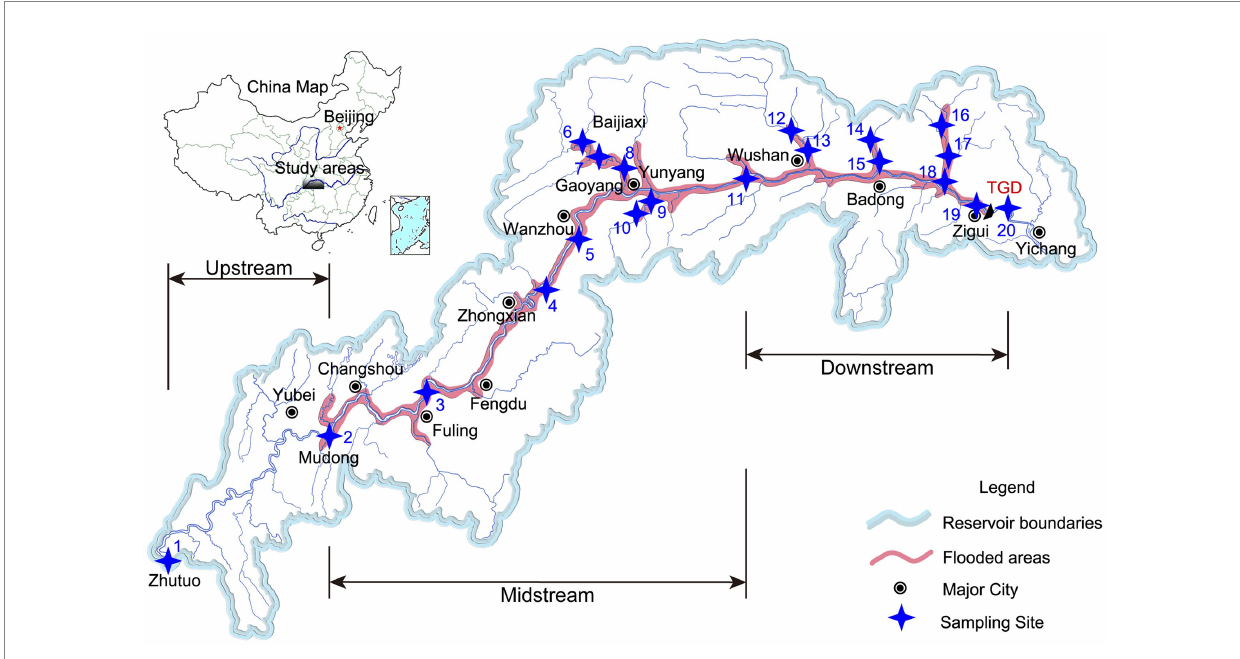
FIGURE 1 Location of sampling sites in the riparian zone of Three Gorges Reservoir,